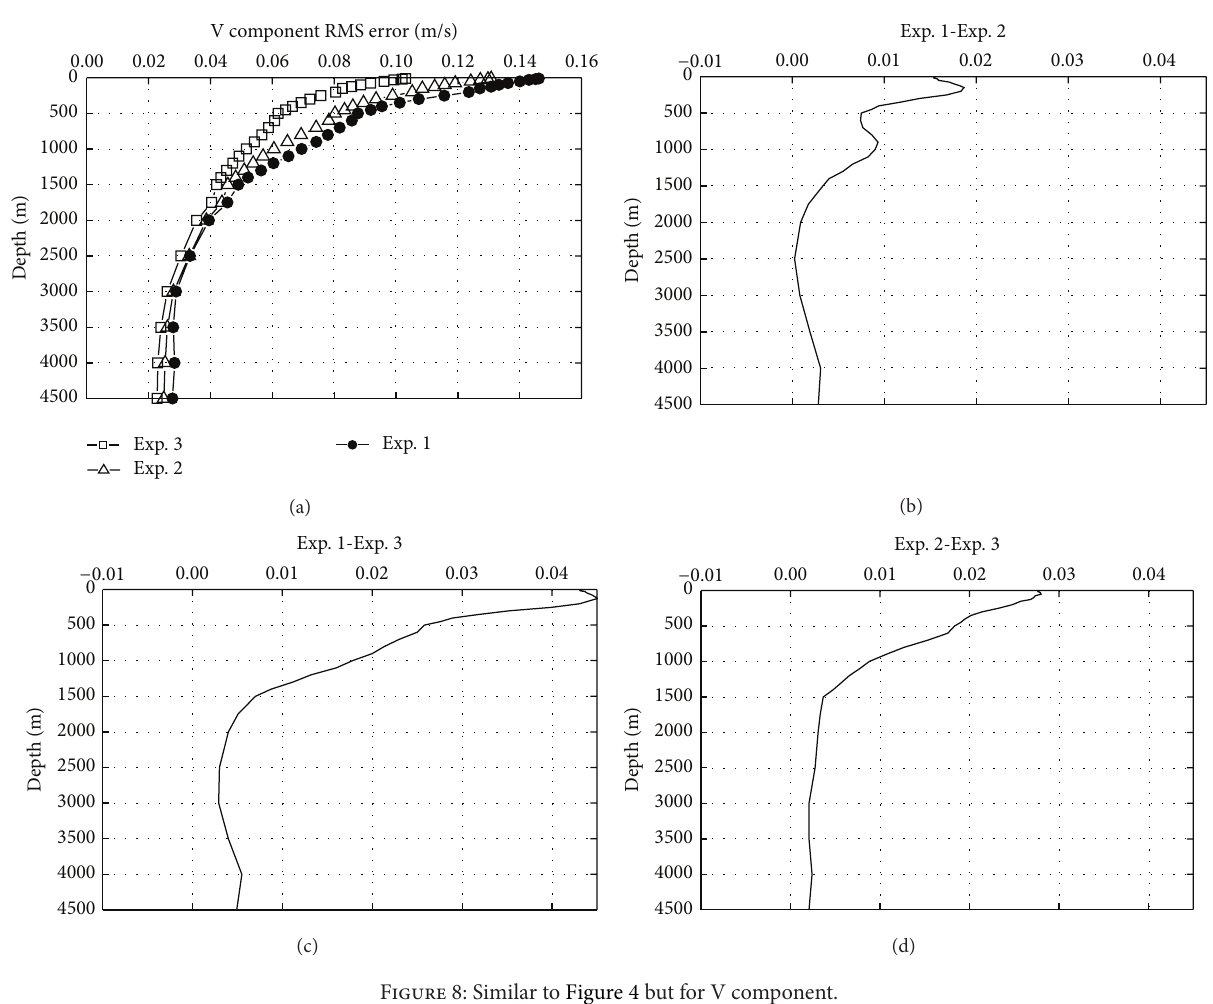
Figure 8: Similar to Figure 4 but for V component.